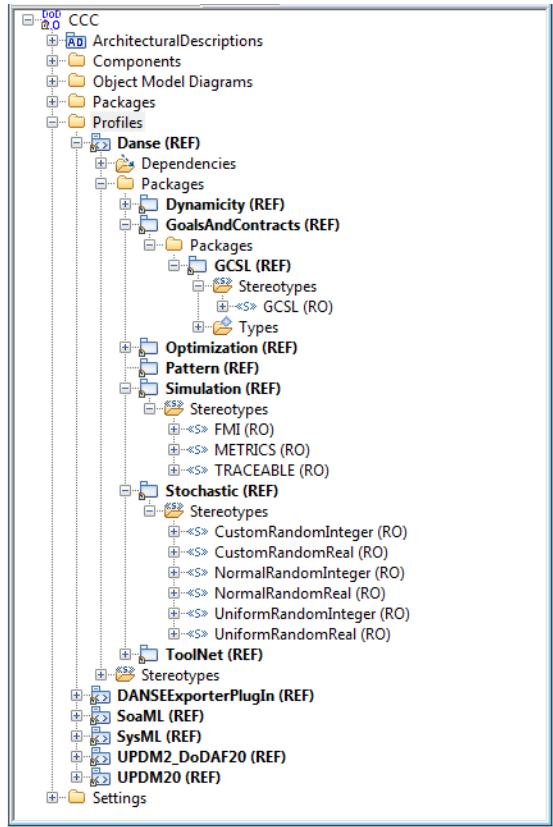
Figure 5. DANSE Profiles and Stereotypes implemented in IBM Rhapsody.